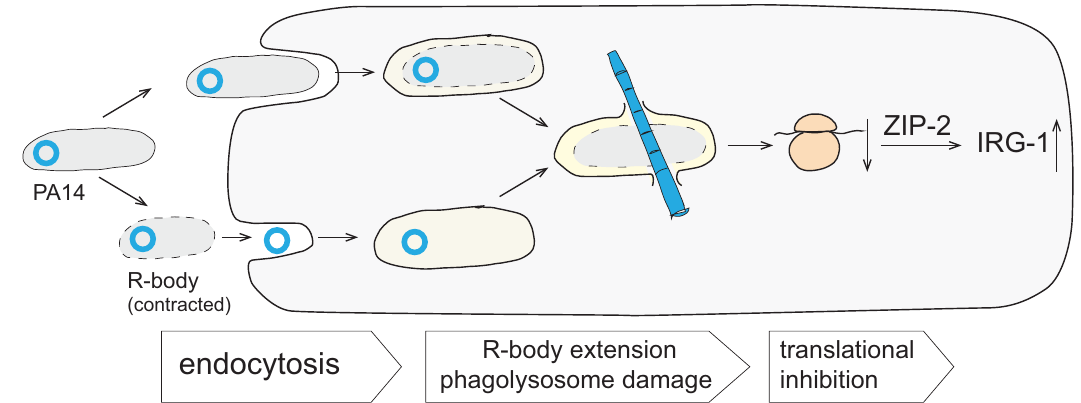
Fig. 8 Model of R-body action within a host cell. R-body-containing P. aeruginosa cells, or contracted R-bodies themselves, are endocytosed by the host cell (e.g., a C. elegans intestinal cell). Conditions of the phagolysosome disrupt the integrity of the bacterial cell wall and/or trigger extension of the R-body. The R-body pierces the phagolysosomal membrane, releasing P. aeruginosa cell contents into the host cell cytoplasm. P. aeruginosa toxins and/or host responses to lysosomal disruption lead to cleavage of the C. elegans ribosome, translational inhibition, and, ultimately,